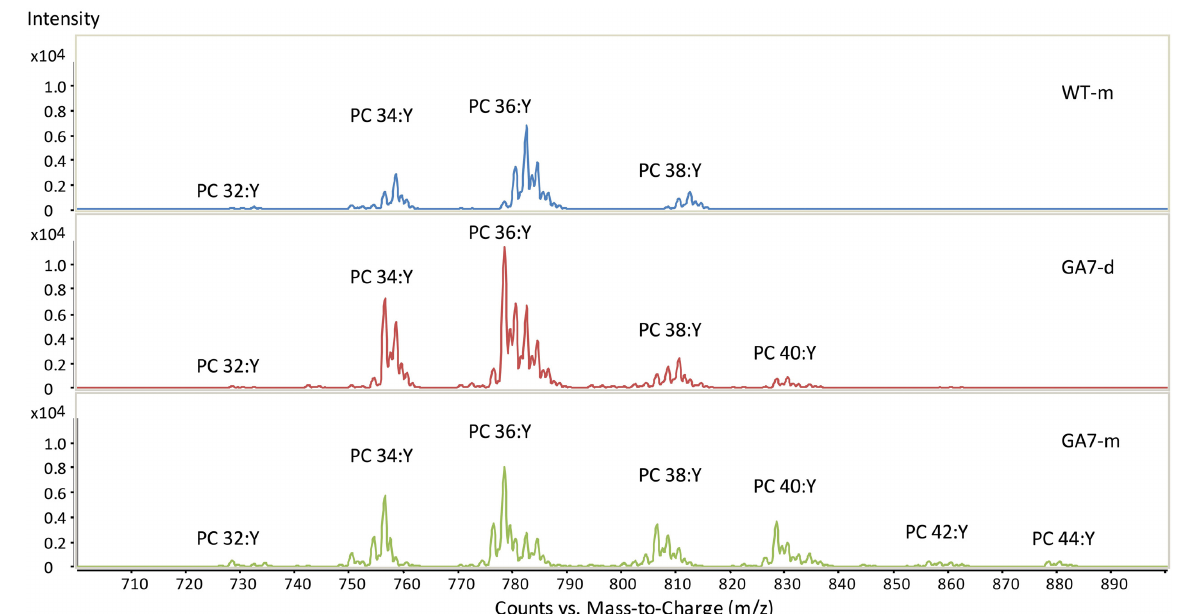
Frontiers in Plant Science | Plant Metabolism and